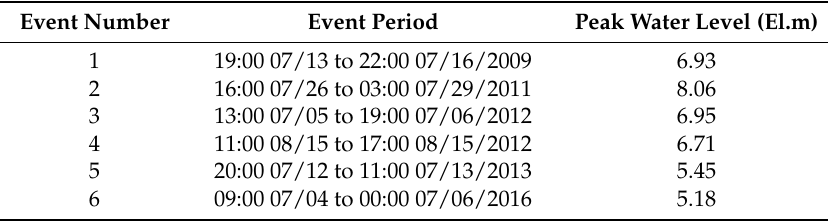
Table 1. Selected flood events for correlation analysis.